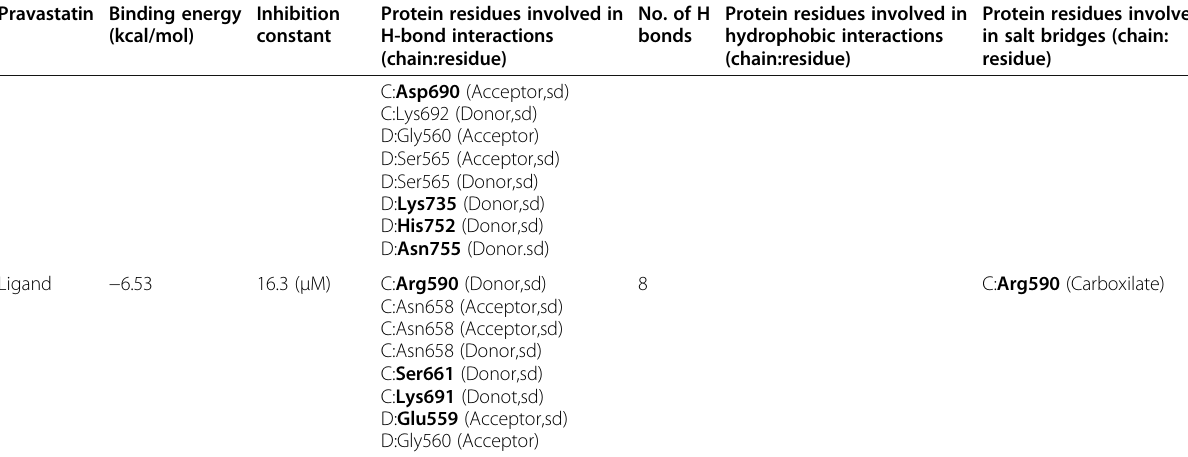
Table 4 HMG-CoAR binding site residues involved in docking interactions with pravastatin and dipeptides, with docking scores